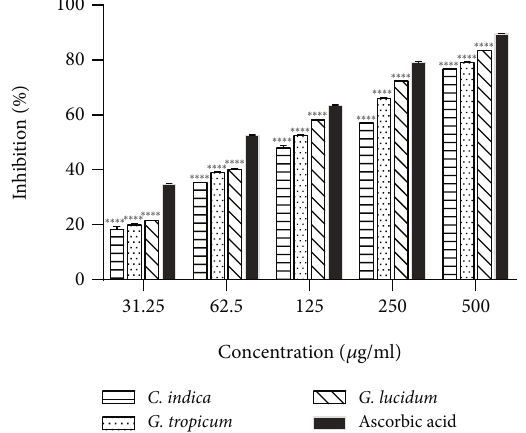
Figure 3: H O radicals scavenging e ff ects of various ethanolic 2 2 mushroom extracts in comparison with ascorbic acid. Results are expressed as mean ± SD ( n = 3 ). ∗∗∗∗ p < 0 : 0001 , ∗∗ p < 0 : 01 vs. standard (ascorbic acid) at each concentration.